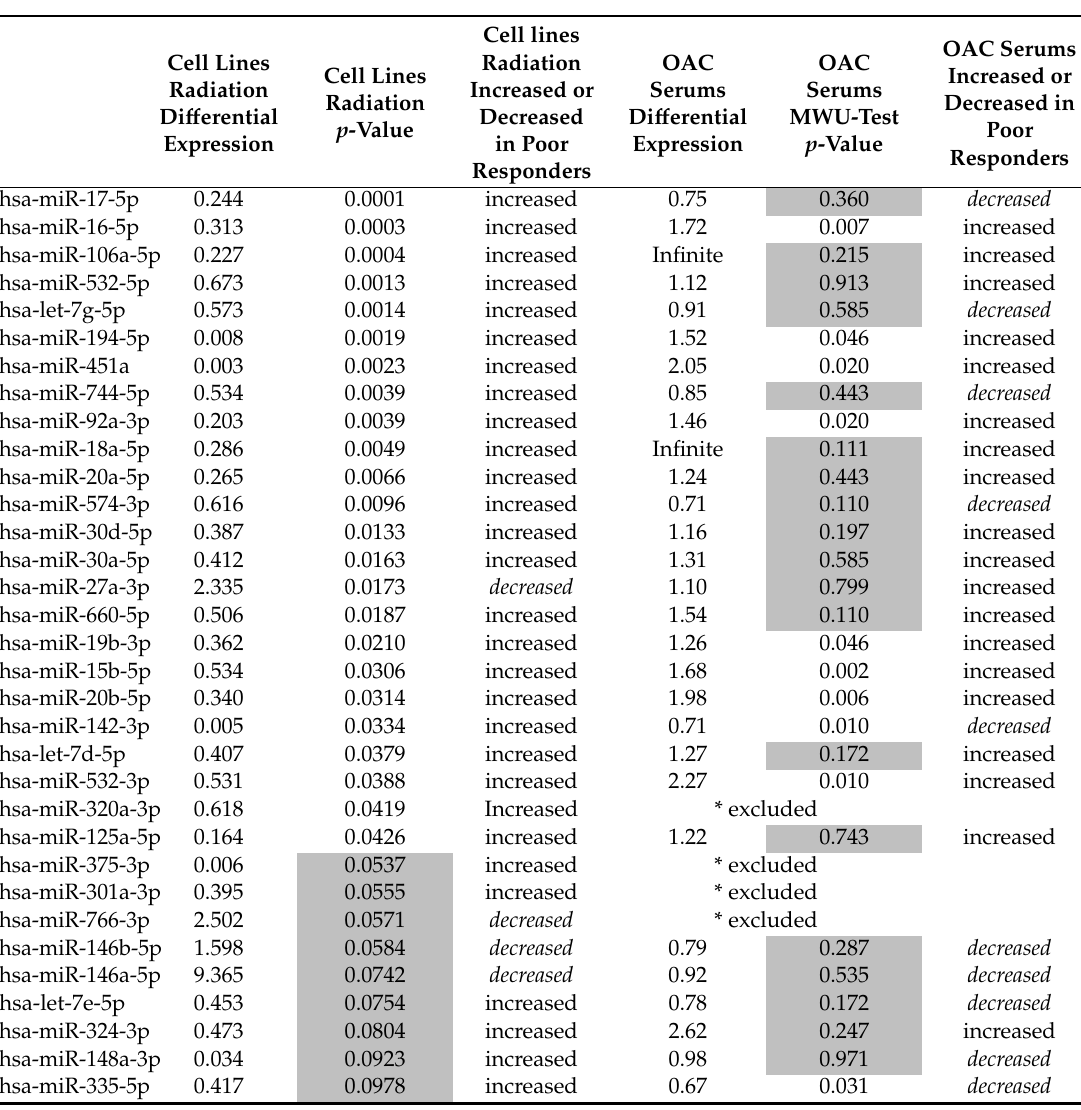
Table 5. Comparison of the expression of miRNAs in OAC cell lines that were associated with response to radiation treatment, with miRNA levels in pre-treatment serum small EVs from patients with oesophageal cancer who responded well vs. poorly to neoadjuvant chemoradiotherapy. Grey highlights p -values >